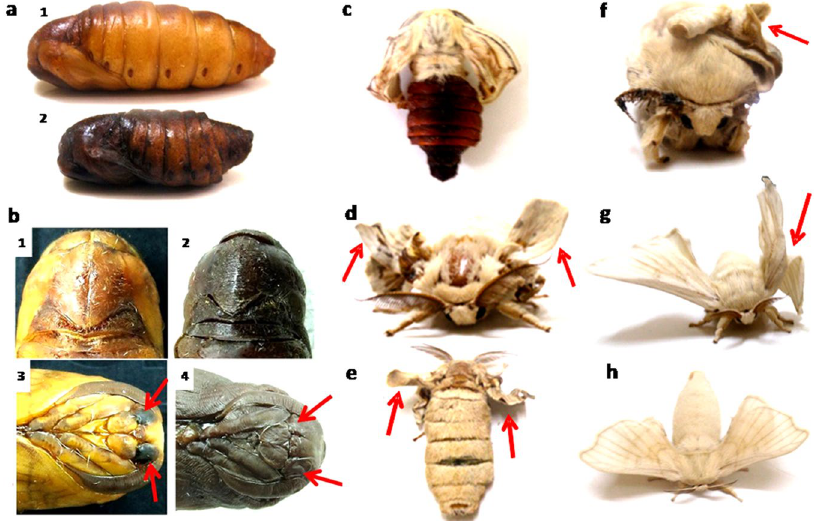
Figure 3. Ligand induced adult-pupal arrest with defects at pupal and adult stage. ( a ) (1) Control pupa (2) Pupa with 250 μ M of DPPA . ( b ) Front and dorsal view of head region of pupa (1, 3) control and (2, 4) with 250 μ M of DPPA . Arrowheads indicate proper eye in (3) and no eye in (4). ( c ) Half-fly pupal-adult arrest with 250 μ M of DPP . Wing deformity (shown with arrowheads) in adult flies treated with ( d , e ) 250 μ M of DPP (front and dorsal view, respectively) ( f ) 250 μ M of TPPA and ( g ) 250 μ M of DPPA . ( h ) Normal wings in control adult fly. The photographs have been taken by one of the coauthors,